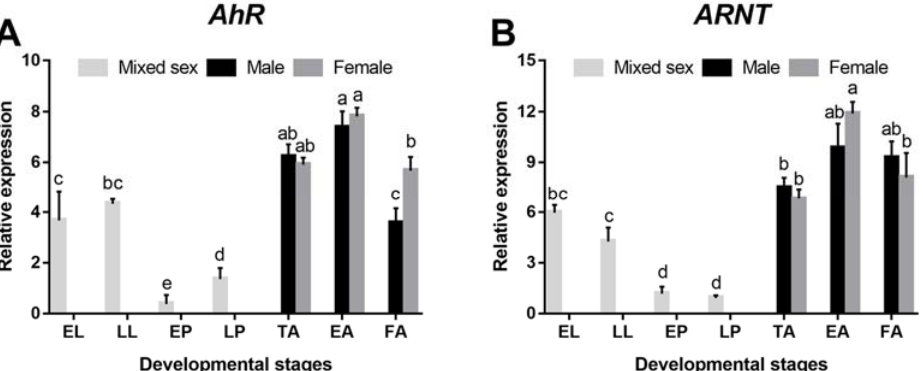
Figure 2. Relative expression levels of AhR ( A ) and ARNT ( B ) in different developmental stages of D. armandi . The relative expression levels were normalized with β -actin and CYP4G55 . Different lowercase letters indicate significant differences at p < 0.05. Post-hoc Tukey tests following one-way analysis of variance (ANOVA). All values are mean ± SE , n = 3. EL, early larvae; LL, late larvae; EP, early pupae; LP, late pupae; TA, teneral adult; EA, emerged adult; FA, feeding adult.